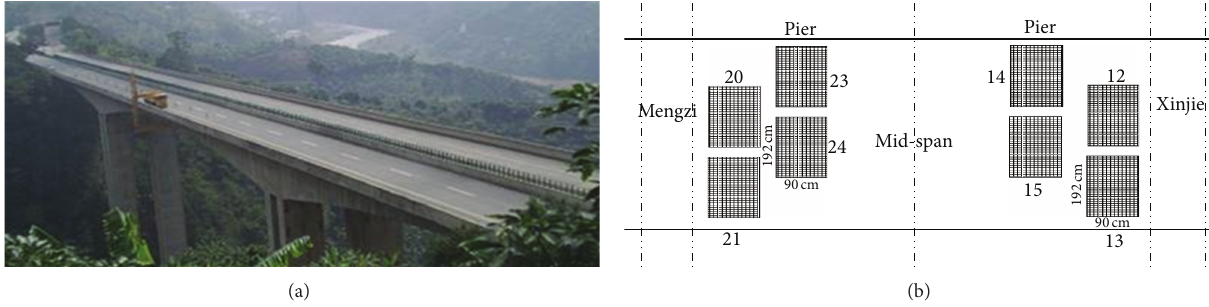
Figure 22: Niupeng Bridge and its sensor layout.